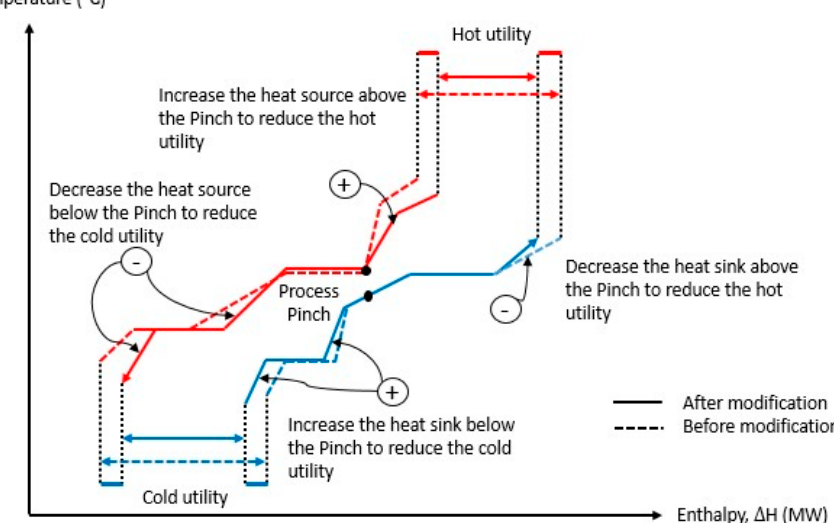
Figure 5. The plus-minus principle (amended from [22]).